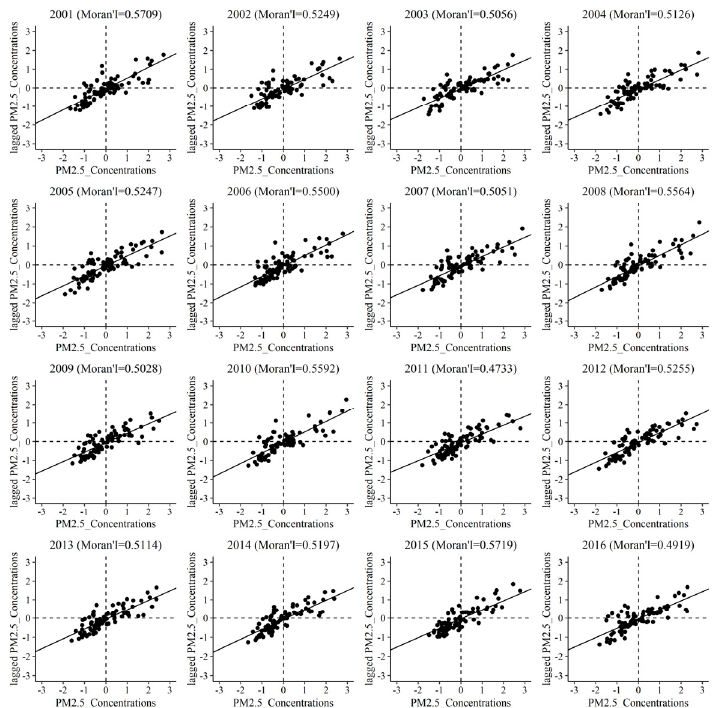
Figure 6. Global Moran’s I scatterplots of PM 2.5 concentrations (2001–2016).